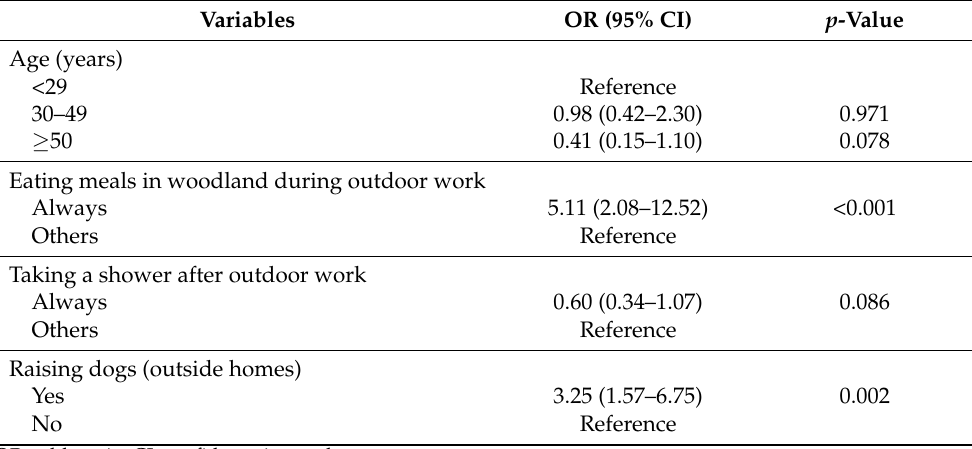
Table 6. Multivariate logistic regression analysis of important variables ( p < 0.10) associated with Lyme disease seroprevalence among National Park Office forestry workers in South